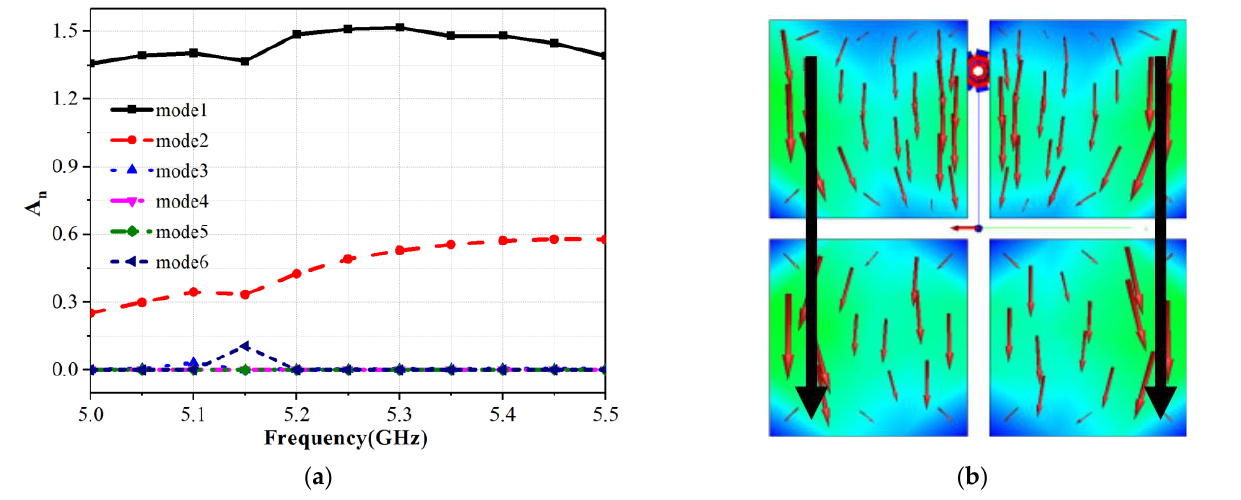
Figure 11. Radiation characteristic modes analysis results of antenna B. ( a ) A 𝑛 ; ( b ) characteristic current distribution at 5.1 GHz.